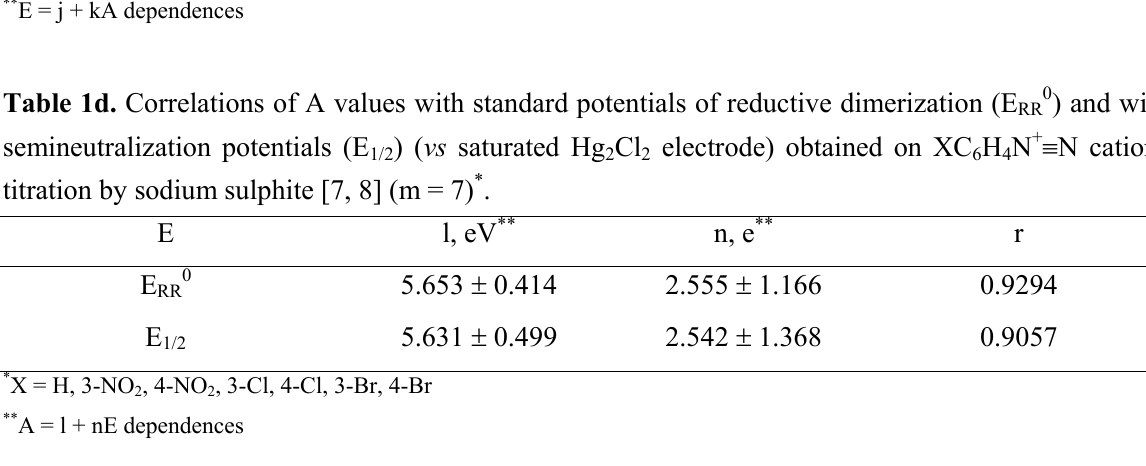
Cl electrode) obtained on 2 2